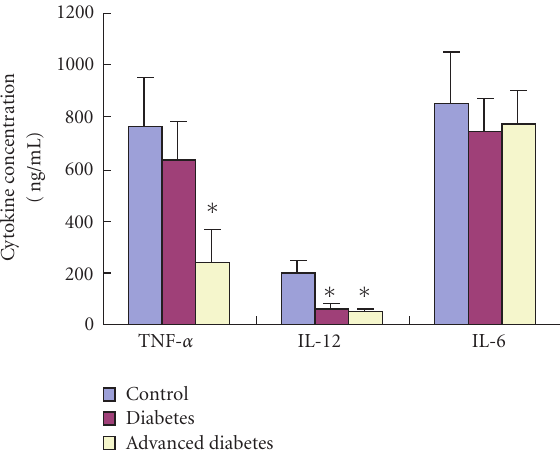
Figure 2. Graphical representation of cytokine quantitation (TNF- α , IL-12, and IL-6) in conditioned medium from Mp cul- tures (10 6 cells/mL) on in vitro stimulation of LPS (40mg/L) af- ter 36 hours. The graph is generated from four separate exper- iments. There were significant di ff erences between control and experimental groups. Note that all cytokines of Mp except IL-6 exhibited a significant reduction in diabetic